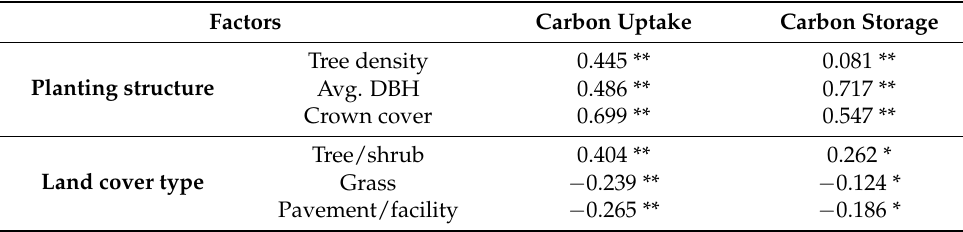
Table 6. Pearson correlation coefficients between carbon offset service and factors. Factors Carbon Uptake Carbon Storage Tree density 0.445 ** 0.081 ** Planting structure Avg. DBH 0.486 ** 0.717 ** Crown cover 0.699 ** 0.547 ** Tree/shrub 0.404 ** 0.262 * Land cover type Grass − 0.239 ** − 0.124 * Pavement/facility − 0.265 ** − 0.186